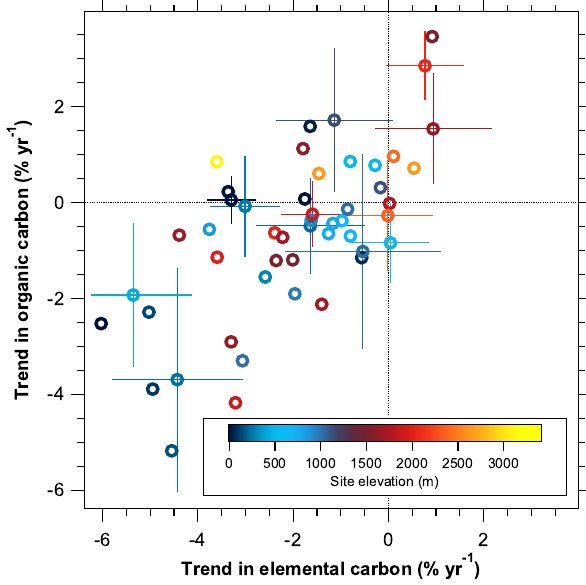
Fig. 7. The relationship between trends in organic and elemental carbon for each IMPROVE site shown in Fig. 2. Uncertainties (1 σ ) for the trend fits are shown for a subset of the